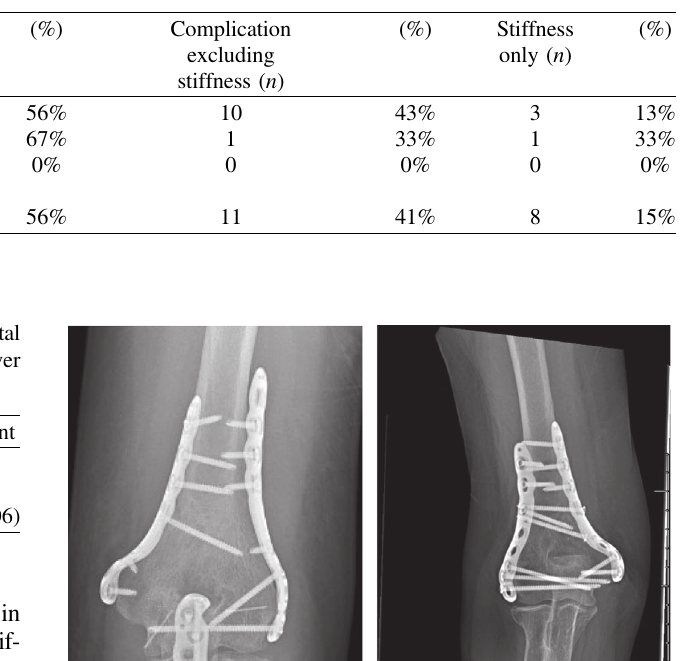
Table 2. Complication rates by device manufacturer.